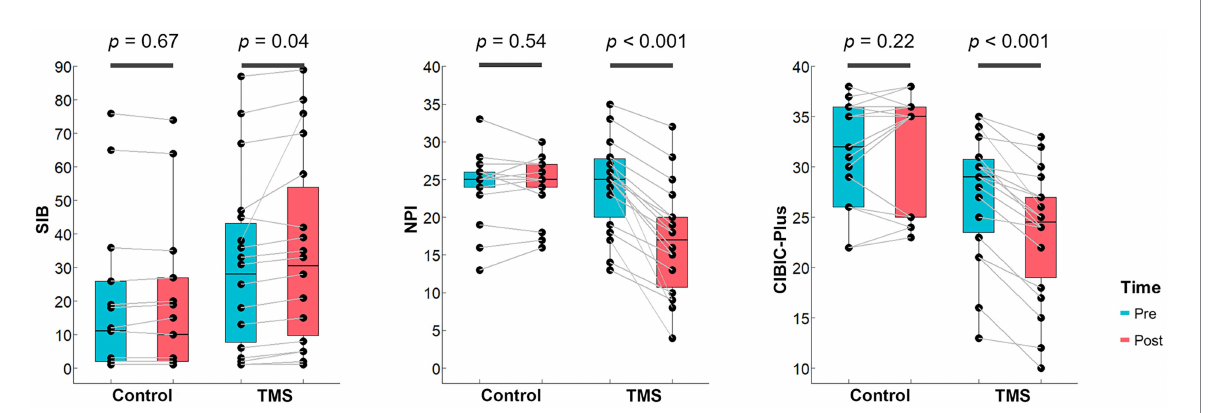
FIGURE 1 rTMS treatment outcomes on neuropsychological performance. Bar plots show the distributions of scores on SIB, NPI and CIBIC-plus that are with significant Group × Time interactions for both groups. The midline in the box represents the median. Each dot denotes 1